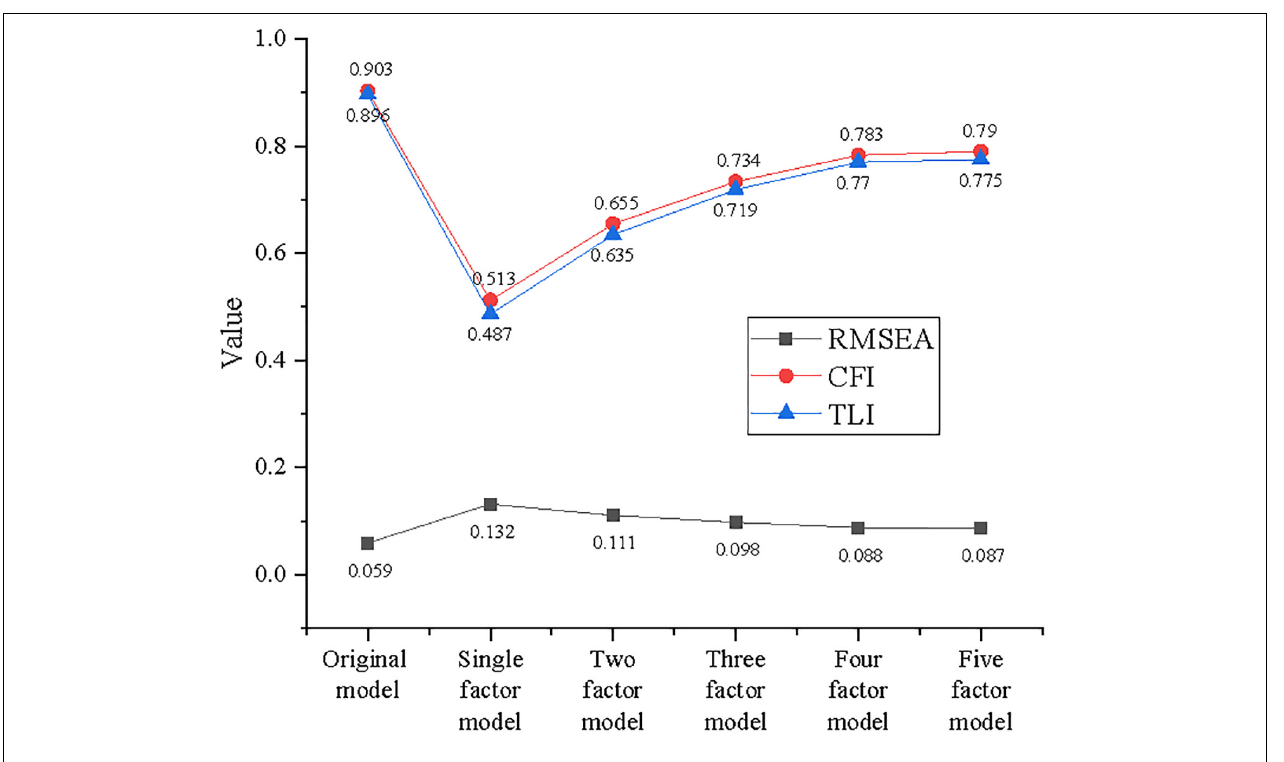
FIGURE 6 | Confirmatory factor analysis (CFA) of the competition model.